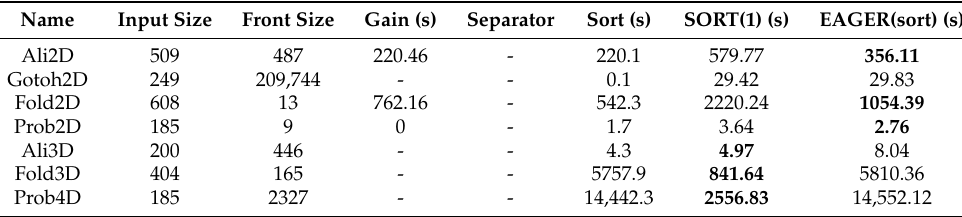
Table 5. Summary of computation times and metadata of test cases. Left: Isolated sorting time gains over Algorithm 1 with the total sum of running times for Merge 1 or Merge 2, respectively (Sort). Input length and the final size of the resulting Pareto front are given. Input size denotes the number of characters in the input sequence. Right: SORT(1) and EAGER(sort) show the full running times of the basic sorted (Algorithm 1, pf sort ) and the Pareto-eager implementations (Merge 1 or Merge 2